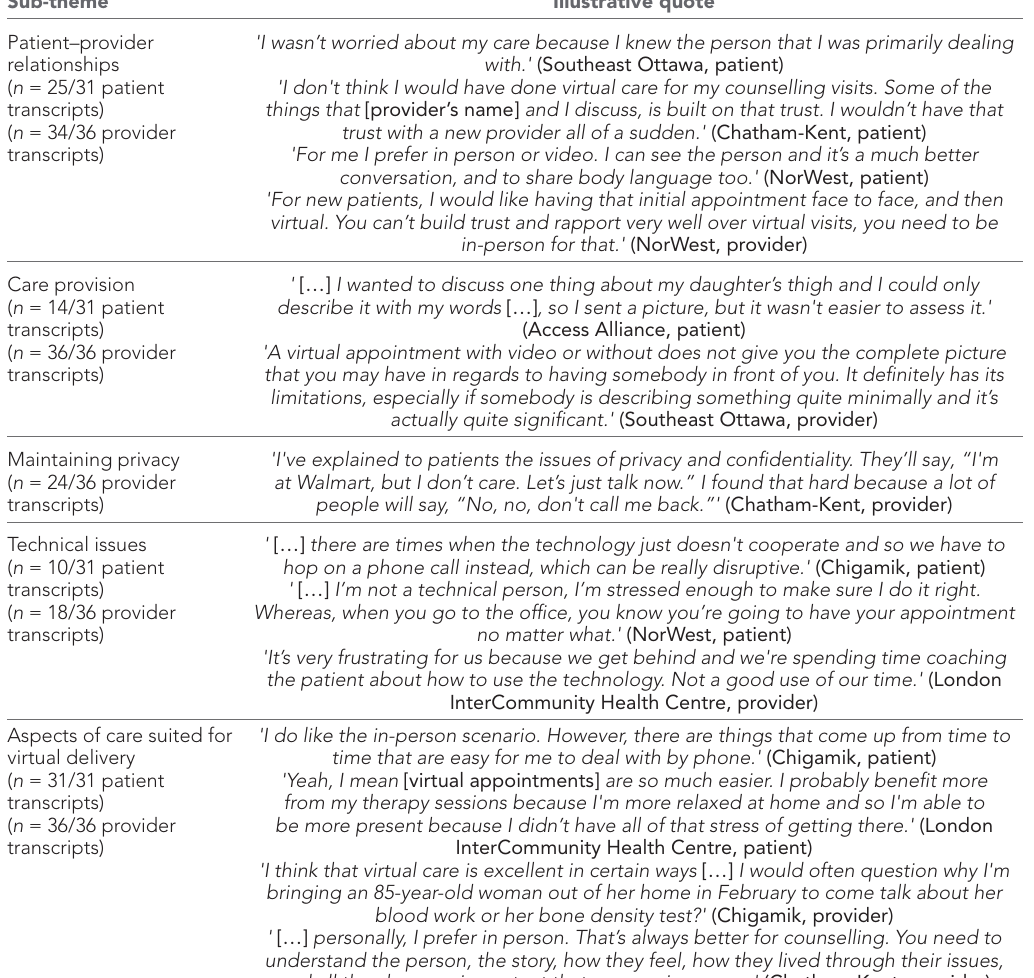
Table 3 Quadruple aim 2: Improving patient and caregiver experience Sub- theme